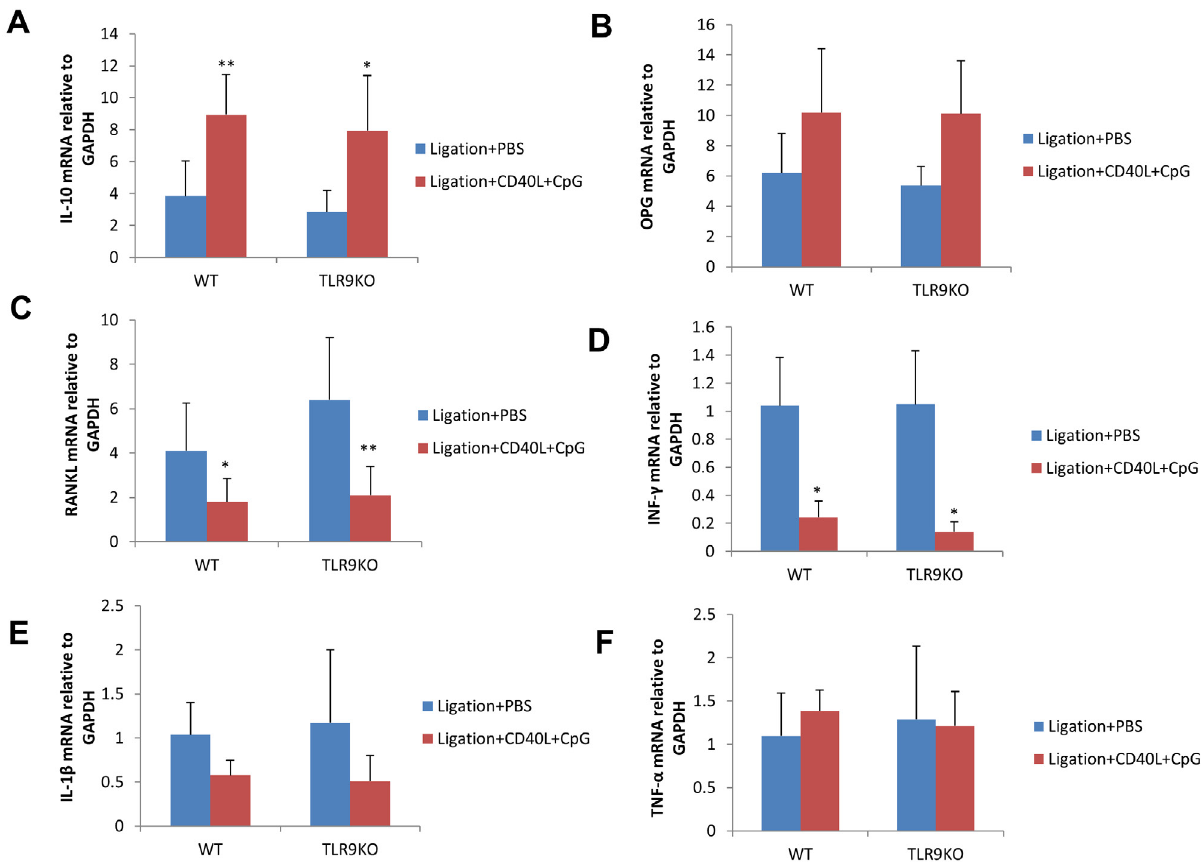
Figure 7- CpG+CD40L increased gingival mRNA levels of IL-10 and decreased gingival mRNA levels of RANKL and IFN-γ in ligature- induced experimental periodontitis of WT and TLR9 KO mice. Silk ligatures were tied around the maxillary secondary molars on day 0 and injection of CpG (1 μM)+CD40L (0.1 μg/ml) or PBS was performed in palatal gingiva on days 3, 6 and 9 in WT mice and TLR9 KO mice. The levels of mRNA expression for IL-10 (A), OPG (B), RANKL (C), IL-1β (D), TNF- α (E), IFN-γ (F) in gingival tissues were detected by qRT-PCR and their relative levels of expression were normalized to the level of GAPDH expression (means±SD, n=4 WT or TLR9 KO mice per group, *p<0.05, **p<0.01, compared with PBS injection